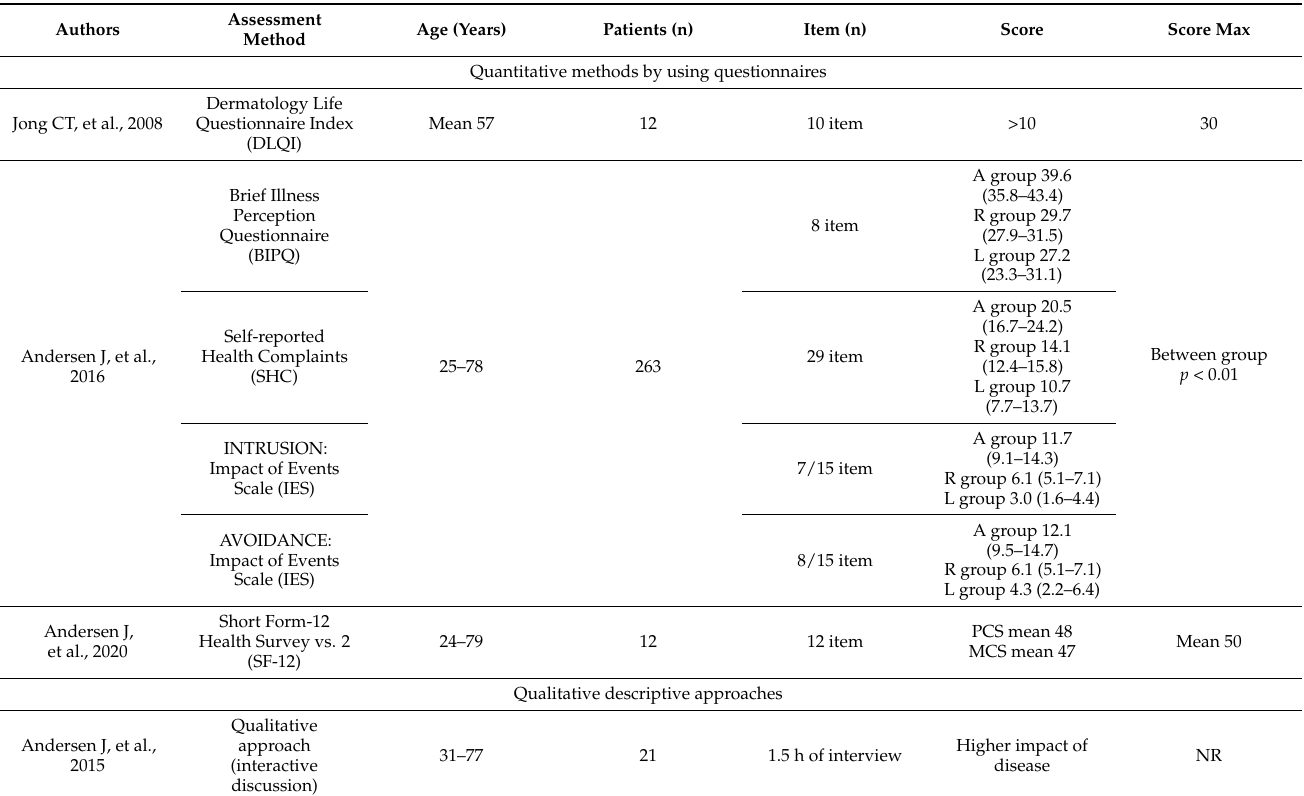
Figure 3. PCT symptoms are divided into three groups of onset: (R) remission, (L) latent, and (A) asymptomatic. The triangle represents the patients’ psychological distress, which increases at the apex. The base of the pyramid represents the major involvement of psychological distress. Table 2. The sum-up of the literature of AHPs: author of publications; methodology approach used for the psychological or QoL assessment; age; number of screened patients; number of the item; field; significative score; the maximum score. NR = not